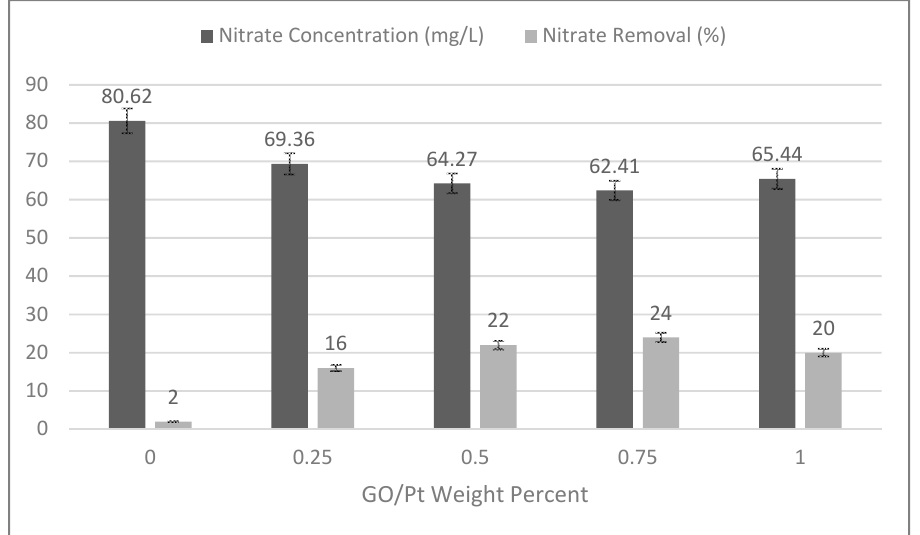
Figure 7. Rejection conditions for nitrate in the polysulfone membranes under different loading percentages of GO/Pt nanoparticles.